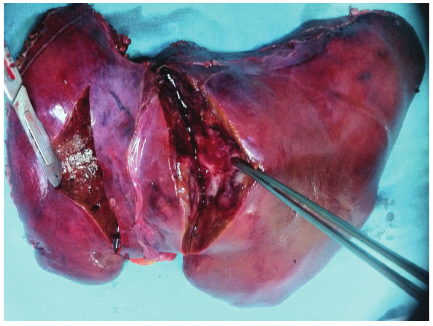
Figure 3: Gross appearance of the resected liver